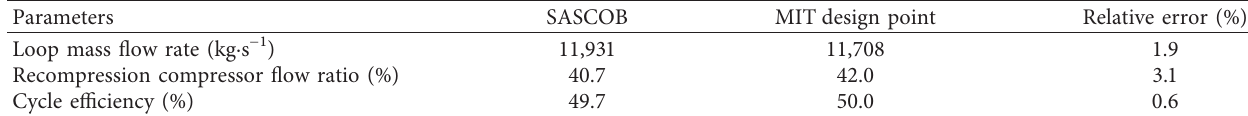
Table 3: Comparison of cycle parameters between SASCOB result and MIT design value. Parameters